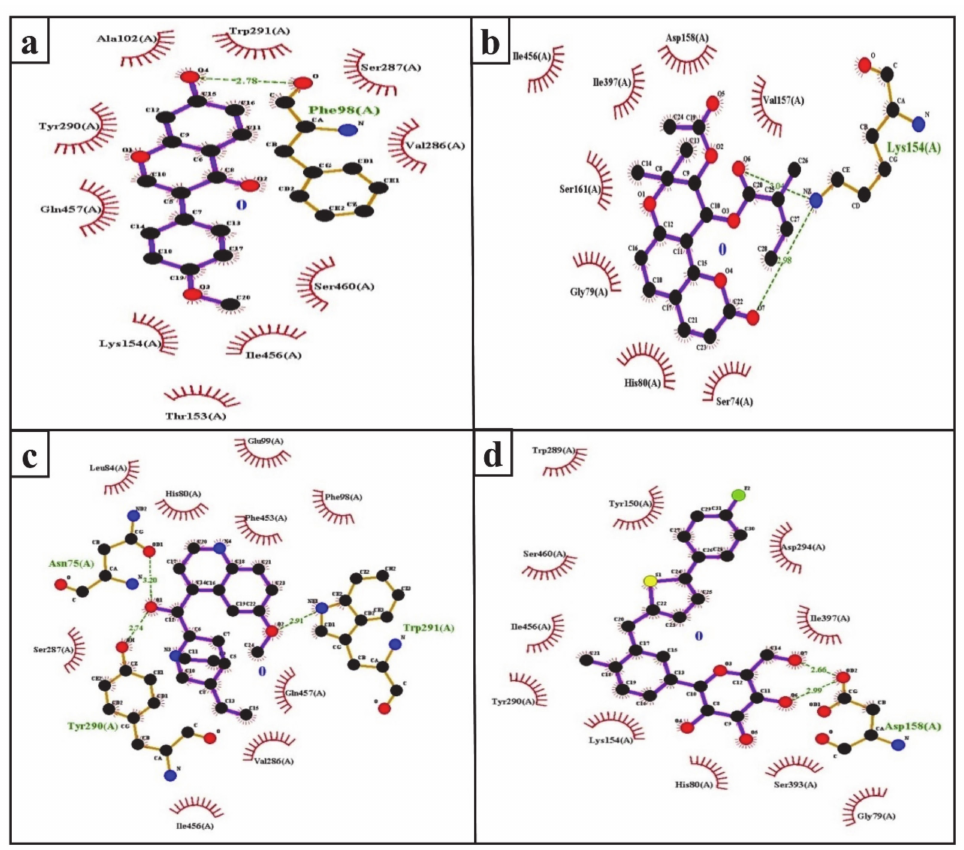
Figure 3. Ligplot analysis of formononetin ( a ), (+)-pteryxin ( b ), quinidine ( c ), and canagliflozin ( d ) in terms of their interaction with SGLT2. The amino acid residues forming hydrophobic interactions are shown as red arcs while the hydrogen bonds are shown as green dashed lines with indicated bond